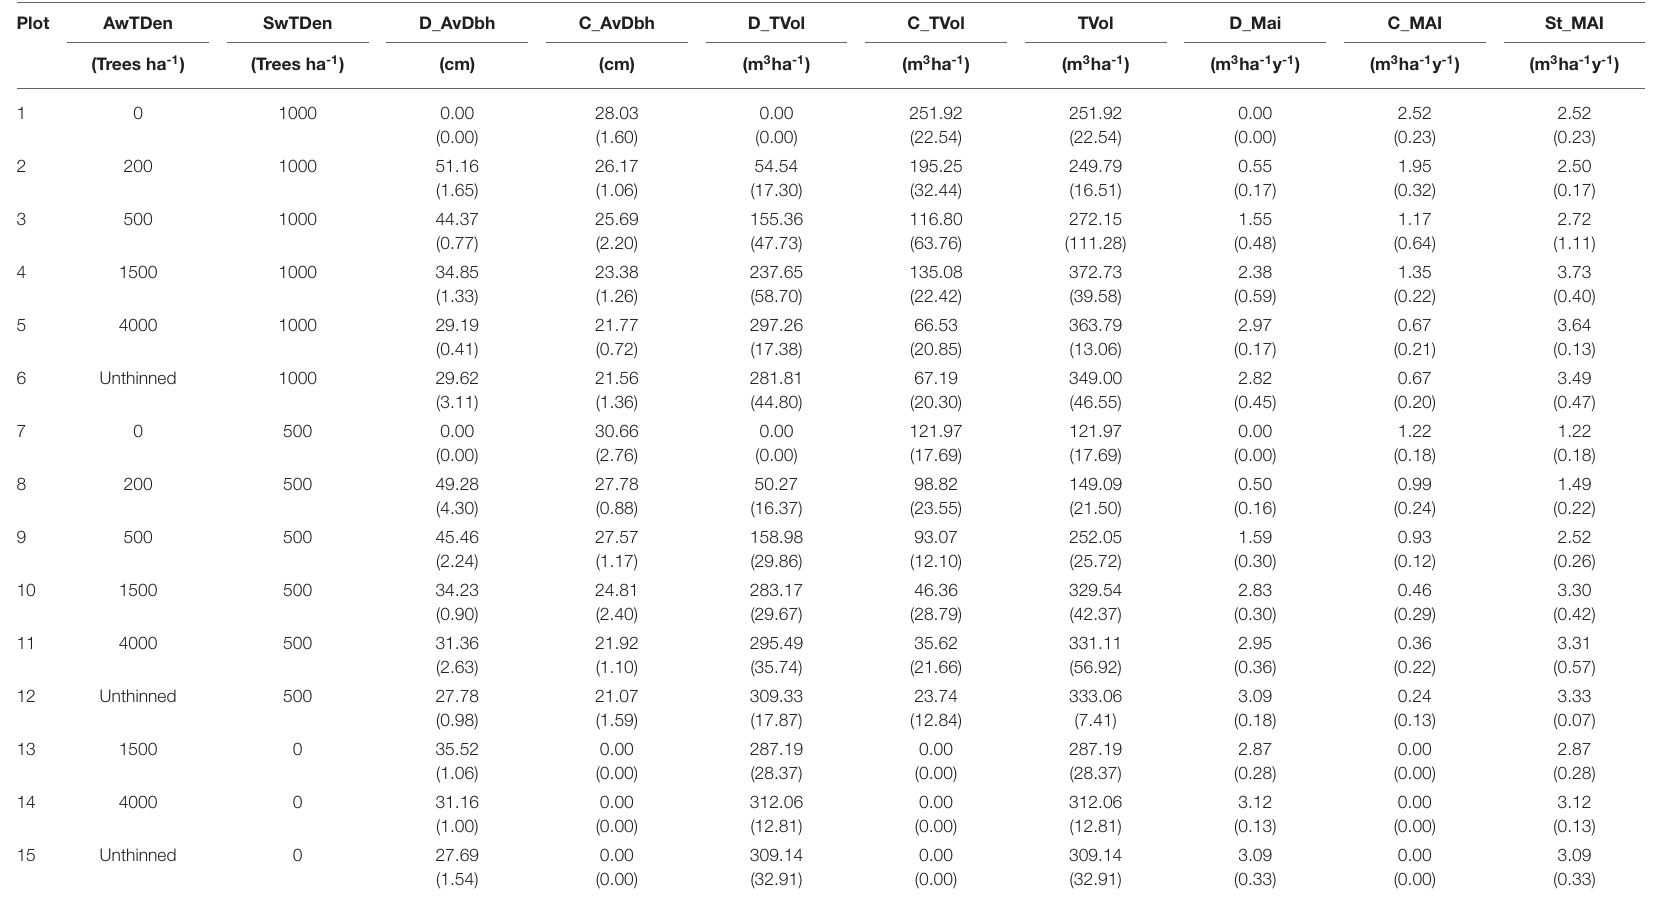
TABLE 6 | MGM forecasts of aspen and spruce diameters, yields and MAI at age 100 for the 15 treatments.